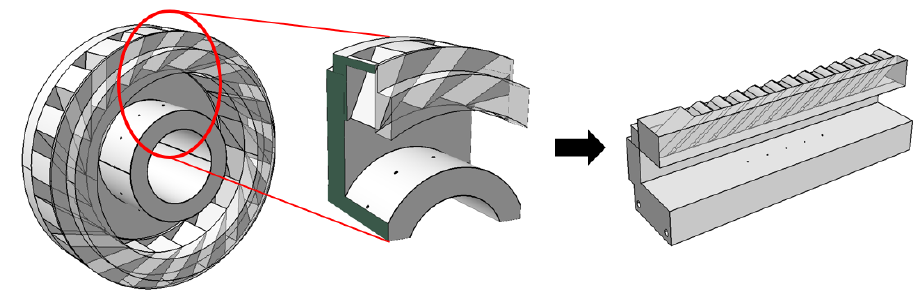
Figure 3. Concept of a radial swirler channel simulation to an L-shape channel.